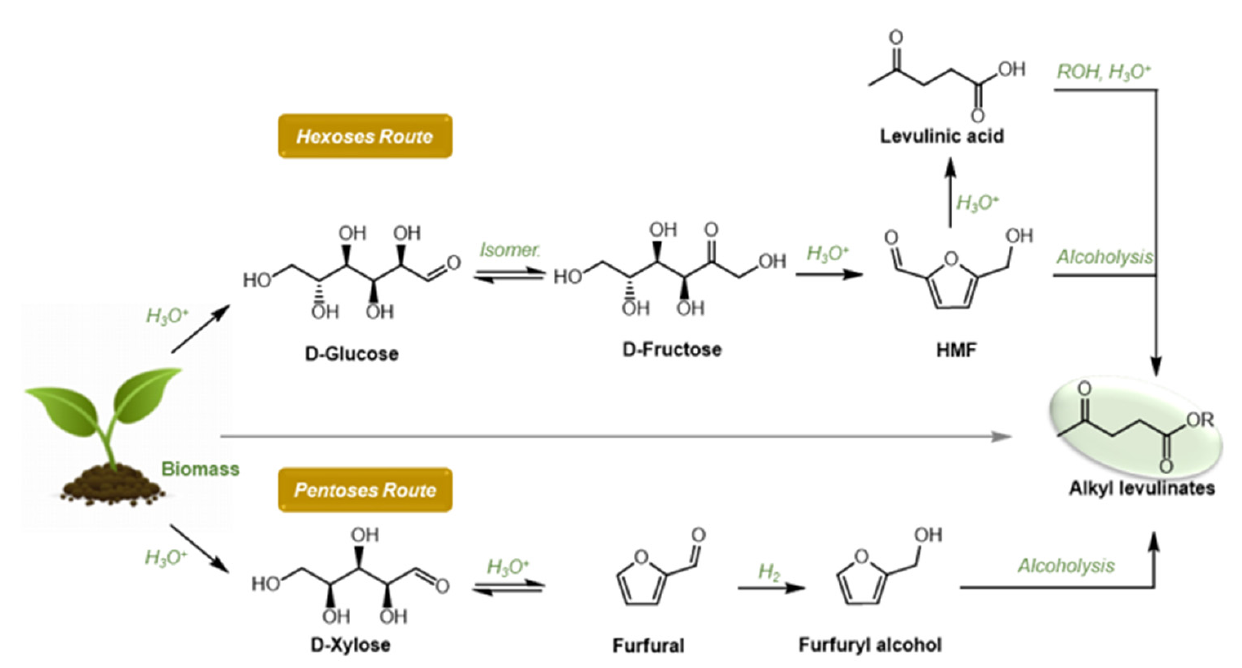
Figure 1. Hexoses and pentoses routed to alkyl levulinates.